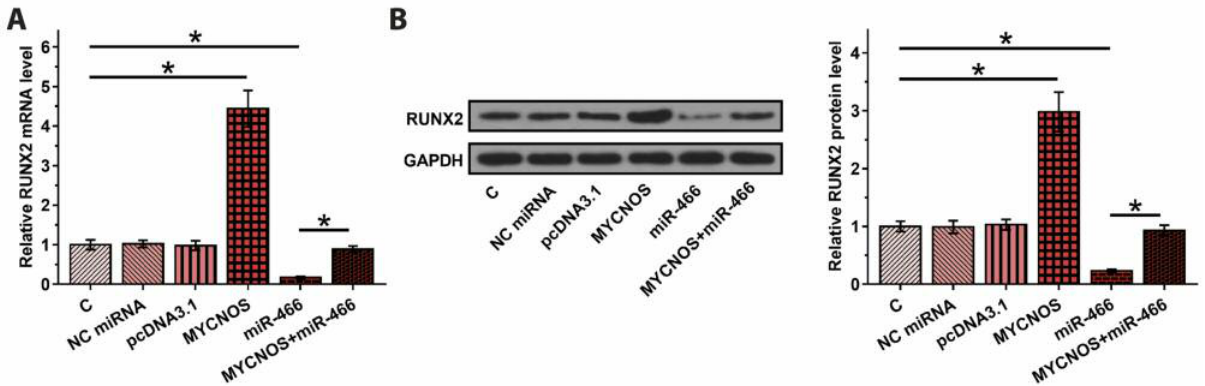
Figure 4. MYCNOS sponges miR-466 to upregulate RUNX2 in 22Rv1 cells. The effects of MYCNOS and miR-466 overexpression on the expression of RUNX2, a confirmed target of miR-466, were explored by RT-qPCR (A) and western blot (B). Data were expressed as mean ± SD values of three biological replicates. * p < 0.05.